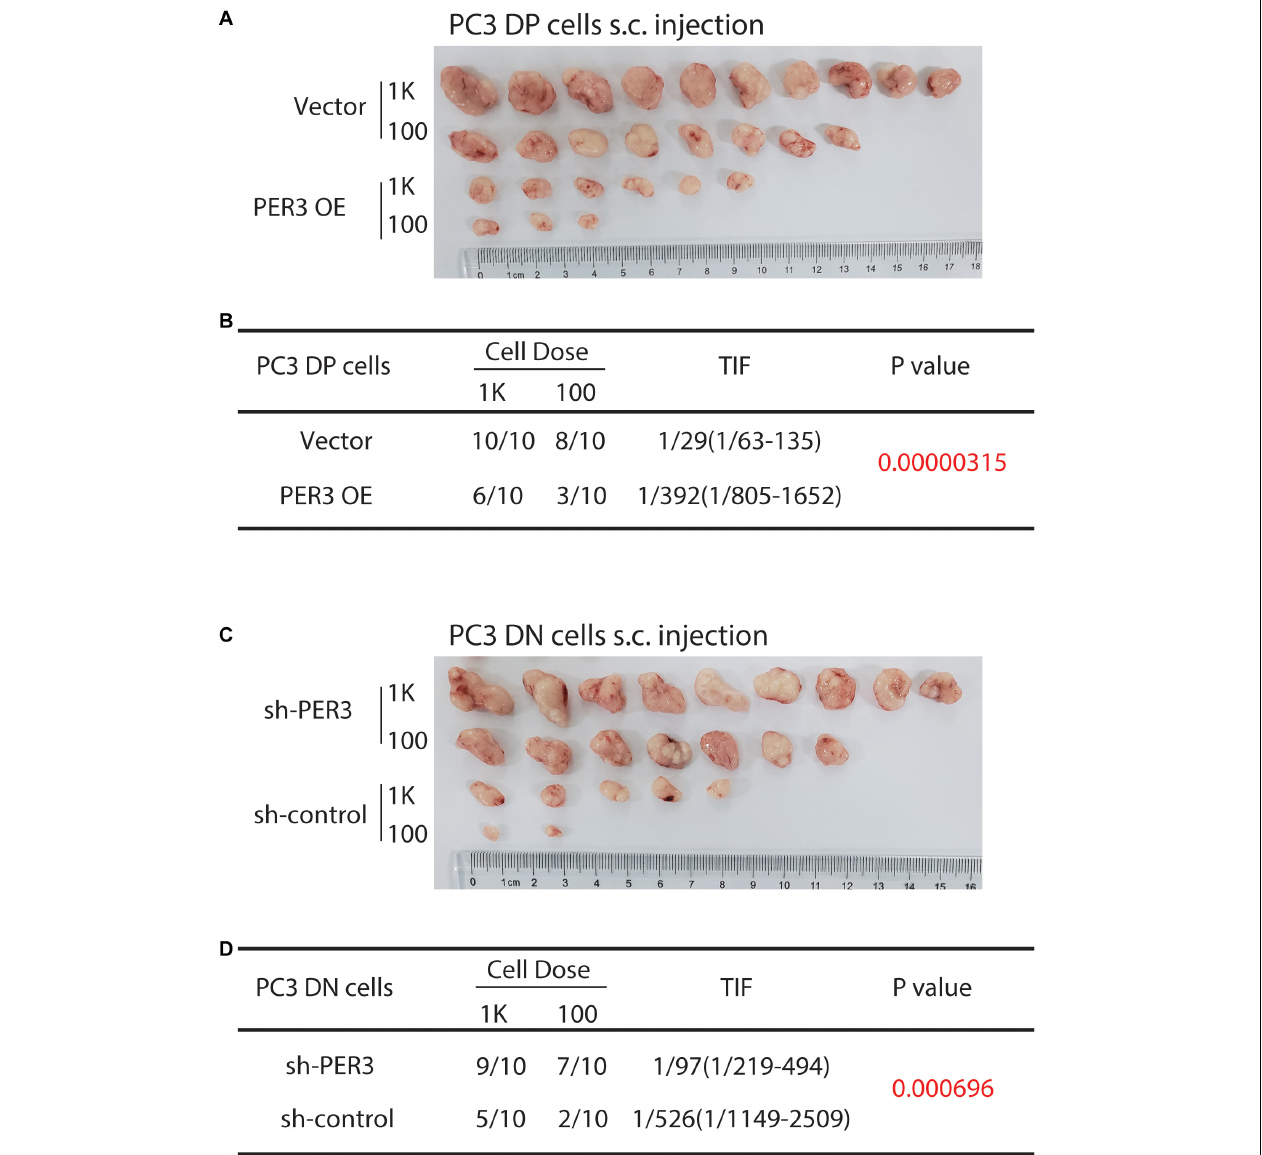
FIGURE 4 | PER3 regulates stemness of PC3 DP cells in vivo . (A,B) PER3 OE in PC3 DP cells inhibits tumor formation. DP cells freshly purified from PC3 cell line were infected with the pGMLV-PE1-PER3 lentiviral vectors (MOI = 20, 48 h) and injected subcutaneously into male NOD/SCID mice at increasing cell doses. Six weeks after implanting, tumors were harvested. Tumor images, incidence and TIF were recorded. (C,D) PER3 KD in PC3 DN cells promoted their tumorigenicity. DN cells freshly purified from PC3 cell line were infected with lentiviral vectors (MOI = 20, 48 h) and subcutaneously injected into male NOD/SCID mice at increasing cell doses. Tumors were harvested after 6 weeks after injection. Tumor images, incidence and TIF were